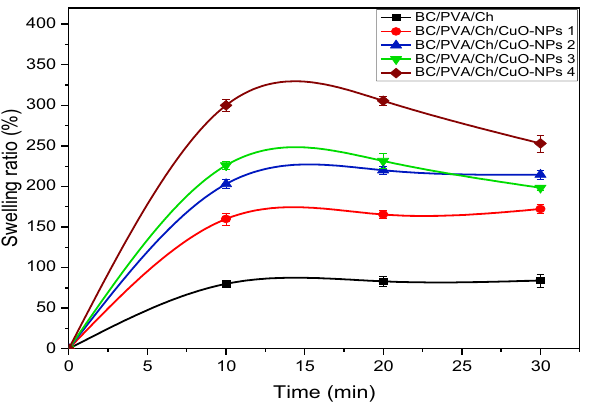
Figure 11. The swelling ratio (SR%) of the prepared BC/PVA/Ch at different concentrations of CuO-NPs.